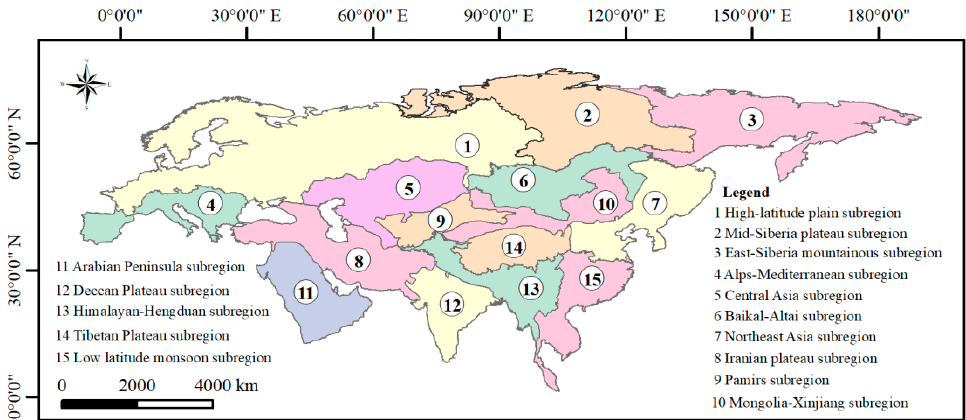
Figure 9. Regionalization results of PPR mountain-hazards developing environments.